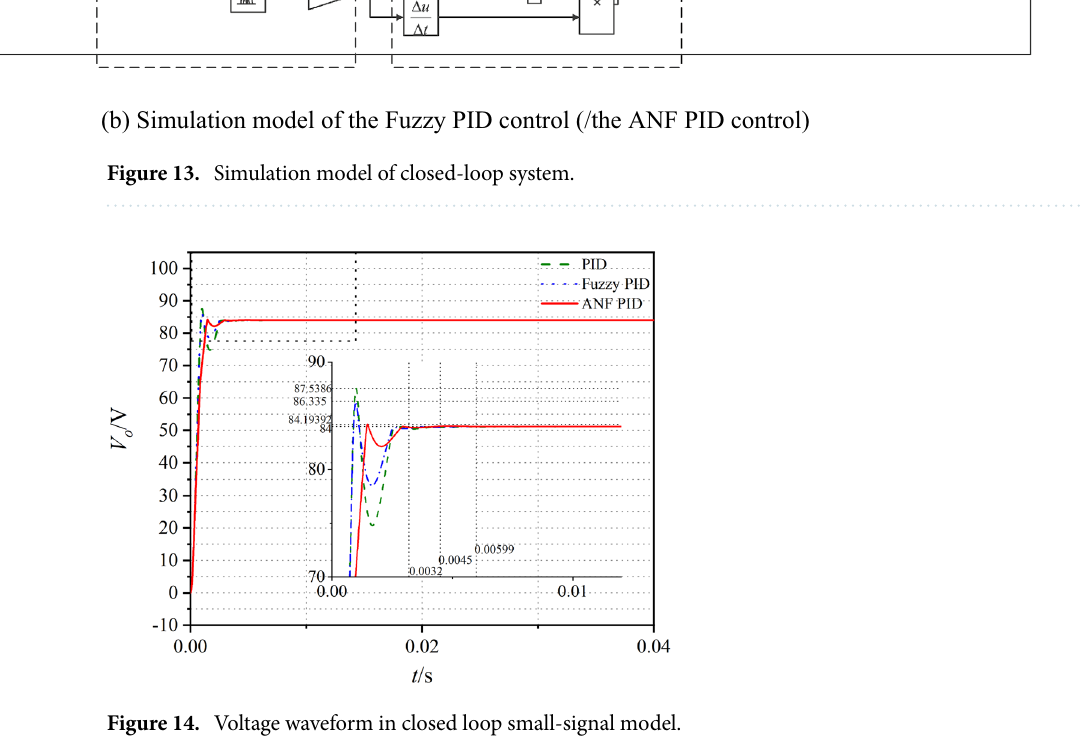
In Eq. (17), σ o means the overshoot of the opened loop system and σ c is the overshoot of the closed loop system with different PID controllers. According to the response curves and characteristic values shown in Fig. 14 and Table 5, the time to steady state, over-shoot and optimization rate of the output voltage are greatly improved when closed-loop controller